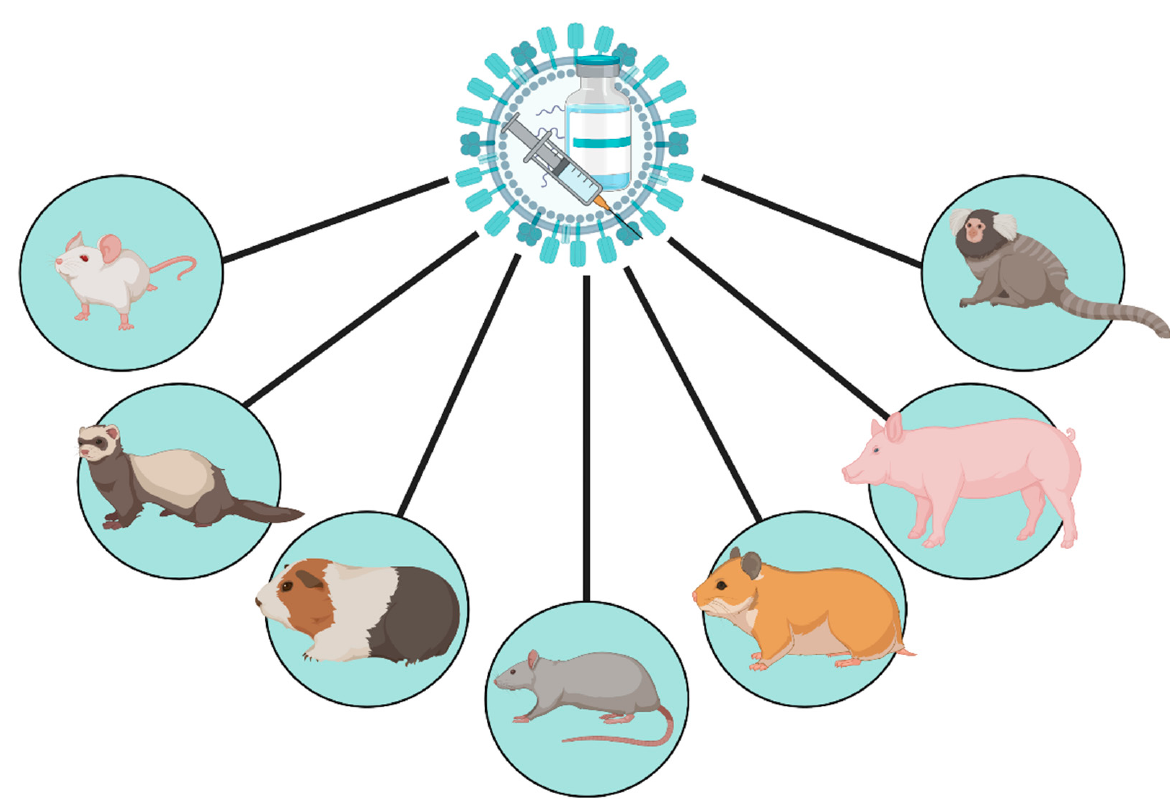
Figure 1. Animal models for influenza virus vaccine development. Mice, ferrets, guinea pigs, cotton rats, swine and non-human primates are important animal models for vaccine development. This figure was created with BioRender.com (accessed on 1 April 2021).